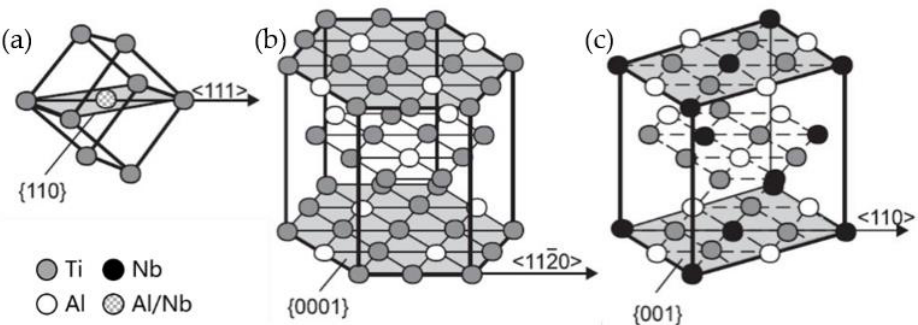
Table 1. Chemical composition of Ti2AlNb alloy by EDS (atomic content ratio, %).